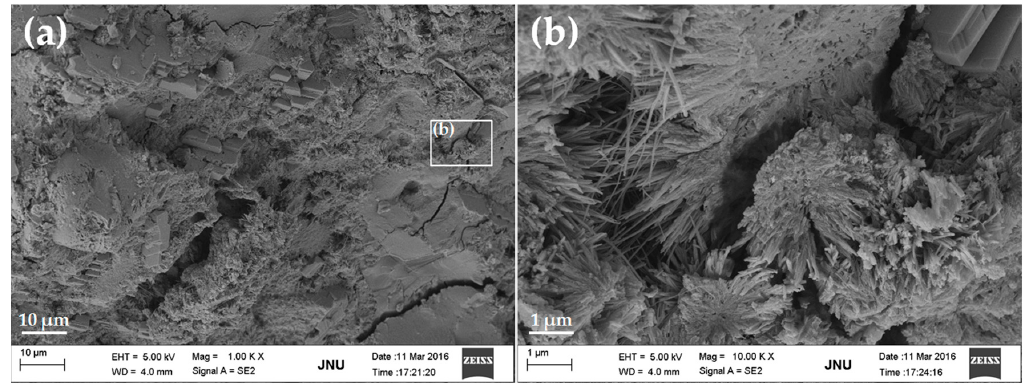
Figure 7. SEM images of fracture surface of plain cement paste: ( a ) typical hydration morphology at low magnification; and ( b ) the local amplification for the area in the white box marked in image ( a ). Images were taken using a Carl Zeiss ULTRA 55 instrument operating at 5.0 kV.